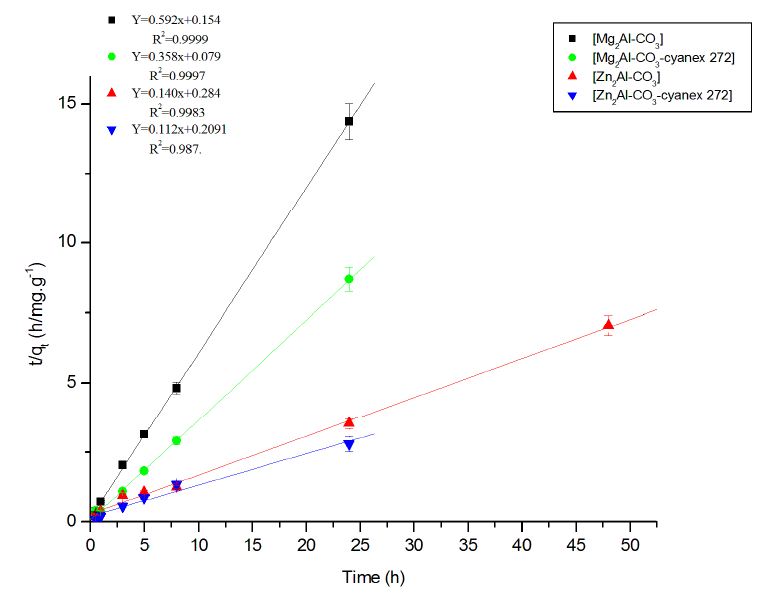
Figure 7. Kinetics of the pseudo-second order of Zn (II) extraction by the different materials. Table 2. Kinetic parameters for Zn(II) extraction by the different materials.